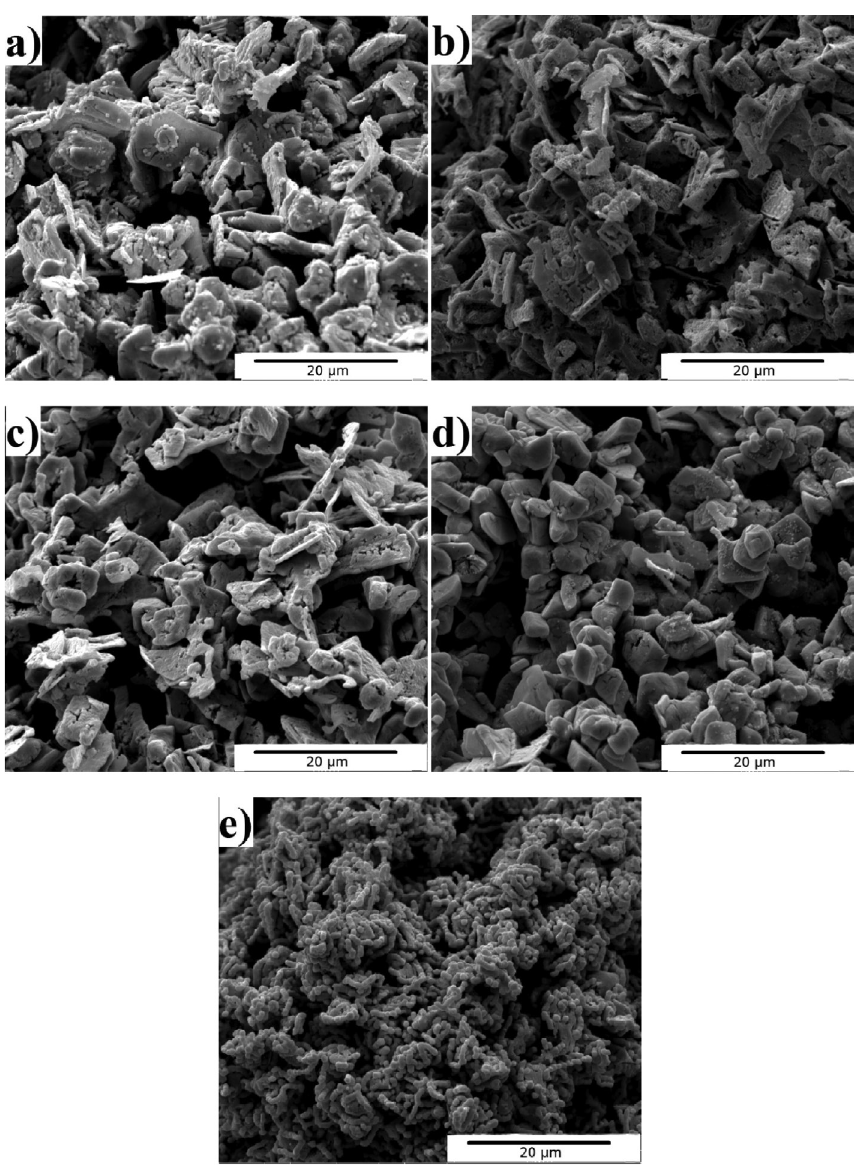
Fig. 6: Morphologies of Mo by reducing MoO 2 powders at 1223 K in different dew points of H 2 : (a) Dry, (b) Dew point: 0 °C, (c) Dew point: 25 °C, (d) Dew point: 40 °C, (e) Dew point: 60 °C (SEM